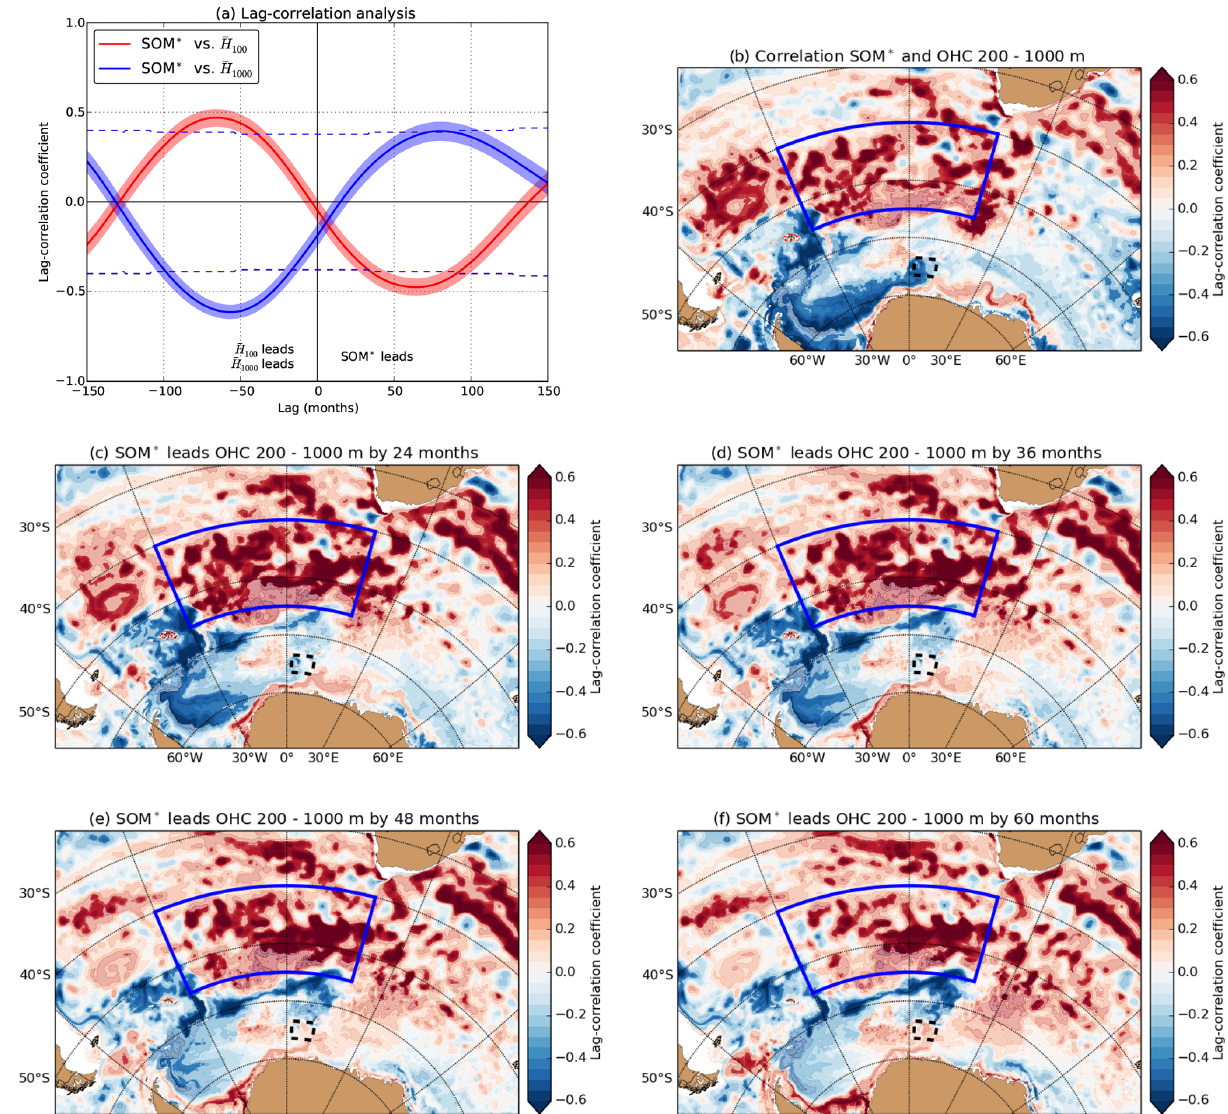
Figure 6. (a) Lag-correlation analysis of the SOM ∗ index, the upper 100m OHC anomaly ( H 100 ) and the 200–1000m OHC anomaly ( H 1000 ), averaged over the polynya region (see time series in Figs. 3d and 4a). A positive (negative) lag indicates that the SOM ∗ time series leads (lags) the OHC time series. The shading indicates the 95% confidence interval of lag correlation, the dashed lines indicate the 95% significance level. (b) Spatial lag-correlation pattern of the SOM ∗ index time series and the H 1000 field for zero lag. (c–f) Same as panel (b) , but now the SOM ∗ index leads the H 1000 field by (c) 24, (d) 36, (e) 48 and (f) 60 months. All time series are detrended and smoothed by a 60-month running mean before determining the lag correlation. The blue-outlined region is the SOM ∗ index region and the dashed outlined region the polynya region. The darker coloured correlations indicate significant (95% CI) lag